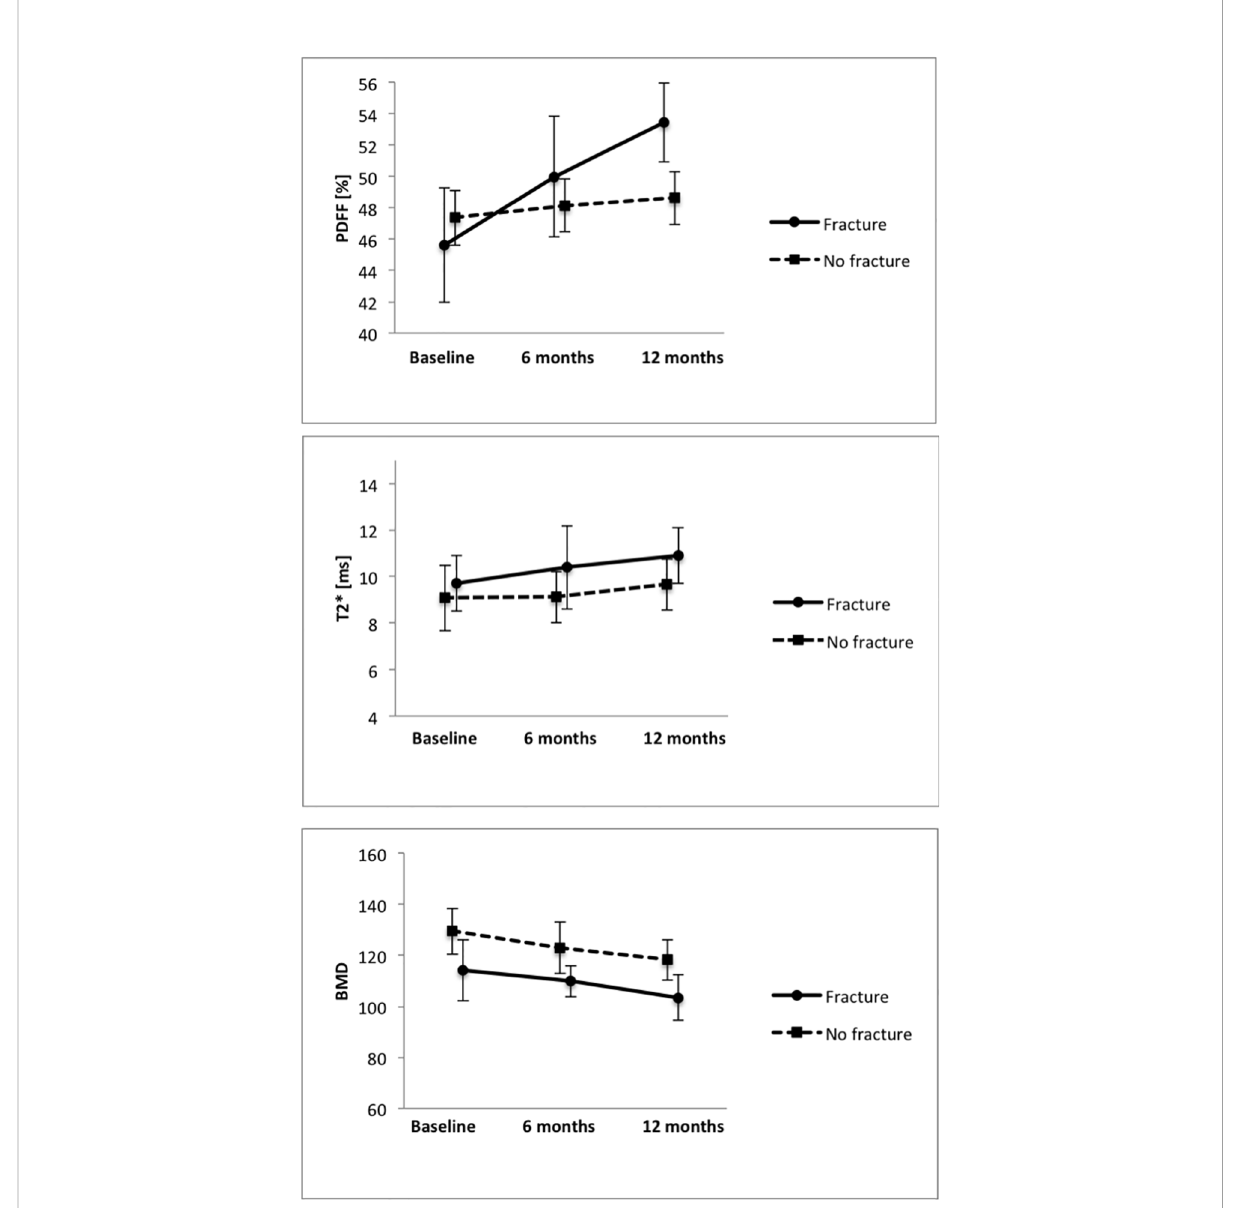
FIGURE 3 Average PDFF, T2* and BMD measurements in the groups with and without VCFs at baseline, 6-month and 12-month